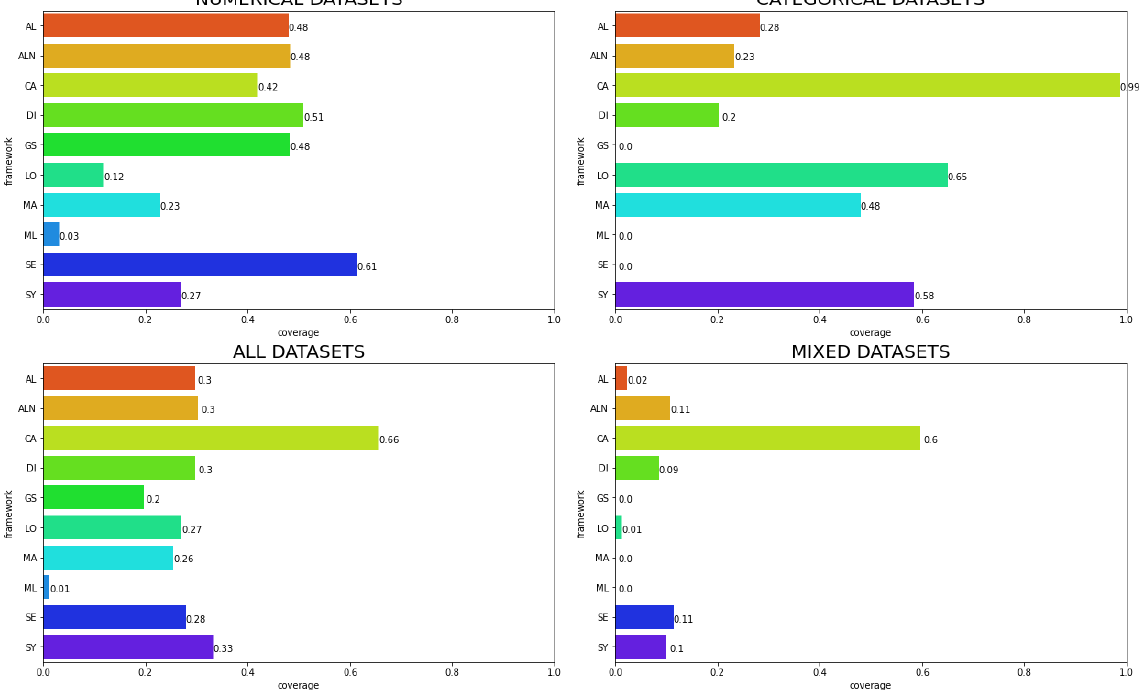
Figure 7. Coverage of algorithms that follows all realistic constraints. Each chart represents a data type, while the bottom left chart analyzes all datasets used in the